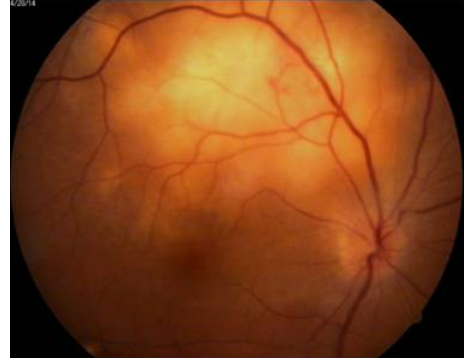
Figure 6: Healing lesion two months after starting anti-tuberculous treatment